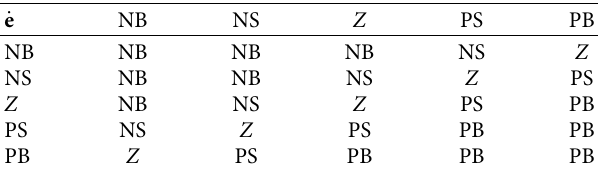
Table 3: 25 fuzzy controller rules